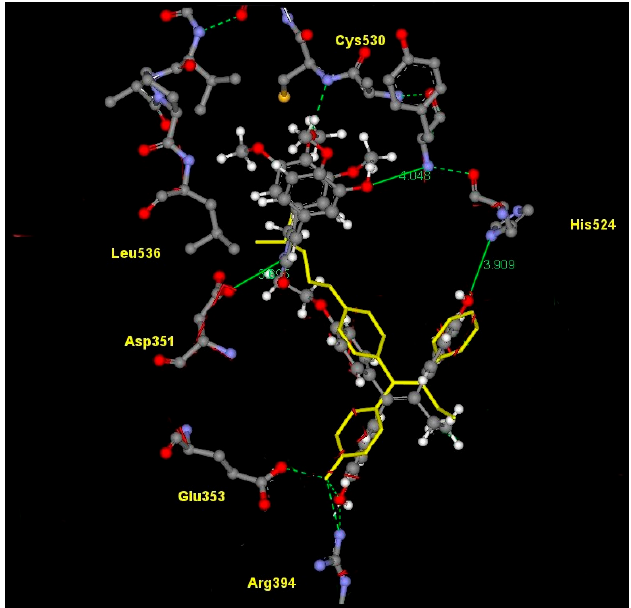
Figure 3. Predicted binding mode of compound 28 in the ligand binding domain of ER α . Highest-ranking docking orientation and predicted receptor interactions for 28 (ball-and-stick representation) in ER α compared to the crystal solution for 4-hydroxytamoxifen (yellow); pdb 3ERT [41]. (H-bond interactions are illustrated as broken lines).